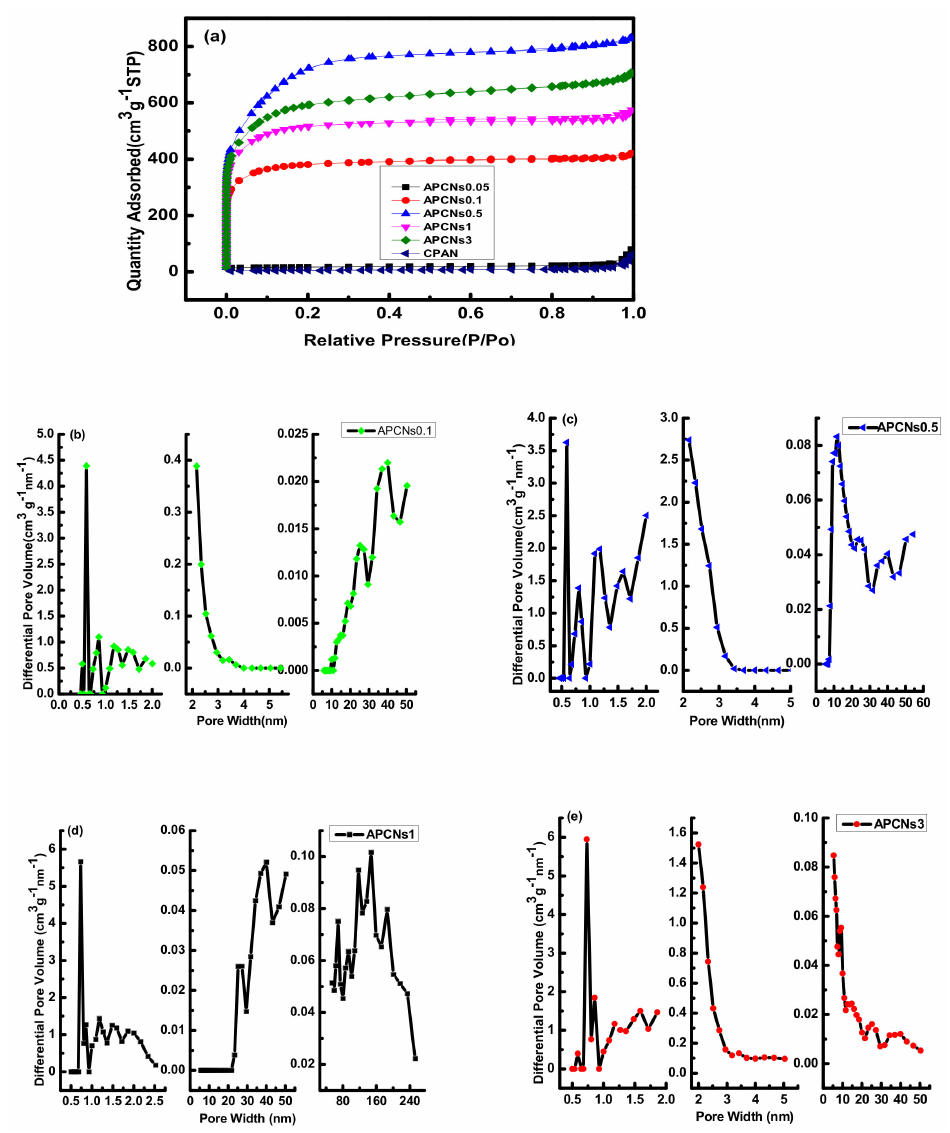
Figure 11. The isotherm adsorption curve and pore size distribution diagram of porous carbon materials with different mass ratios of KOH and OPAN: ( a ) adsorption isotherm curve; mass ratio of: ( b ) 0.1:1; ( c ) 0.5:1; ( d ) 1:1; (e)